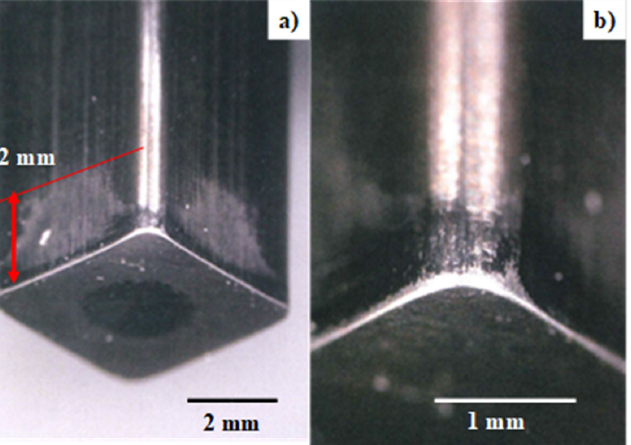
Figure 5. The CS ‐ YXR7 punch after fine blanking AISI304 plates with a thickness of 3 mm in three shots and pure titanium plates with a thickness of 2mm in two shots: ( a ) overview of CS ‐ YXR7 punch after fine blanking and ( b ) the punch edges and punch corner.